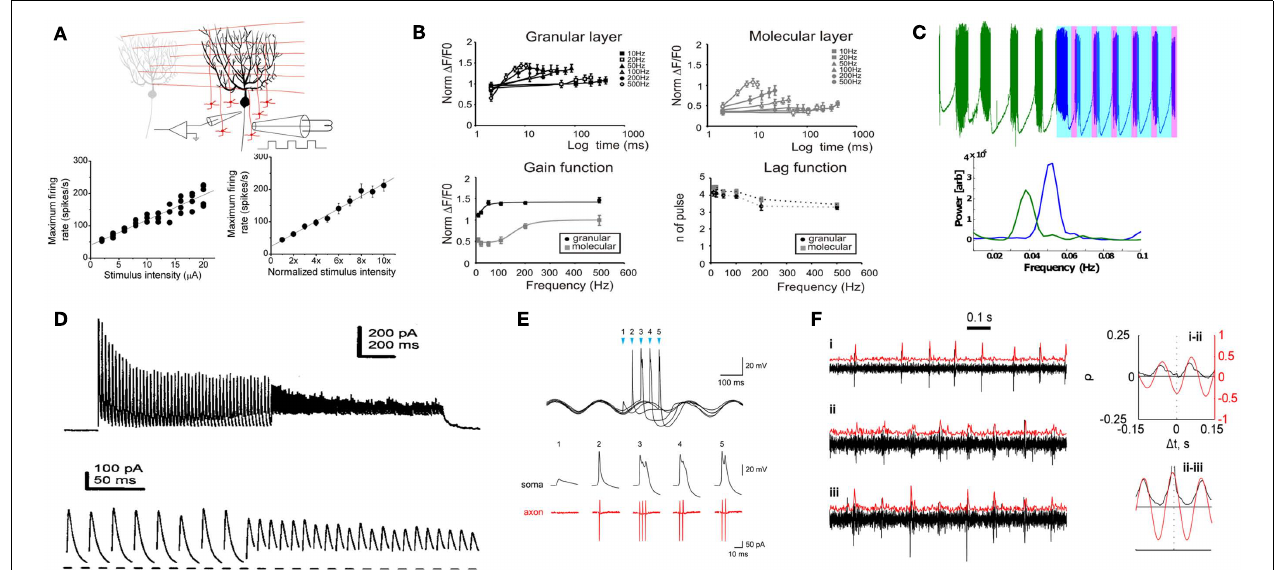
(artificial stimulation). At higher frequencies of inhibition (from 50 to 100Hz), the efferent cells to the Purkinje are depressed more (Telgkamp and Raman, 2002). (E) Phase-locked modulation of olivary output to sub-threshold oscillations.The firing increases at the peak of the underlying oscillation (frequency modulation), which provides the climbing-fiber input to the Purkinje neuron (Mathy et al., 2009). (F) Phase locking of different Purkinje neurons inhibiting a cerebellar neuron.The top two traces show synchrony between spikes (correlation measured on right), whereas the bottom two traces display little correlation.This form of phase locking can act as an edge detector for the cerebellar nuclei (Jacobson et al.,